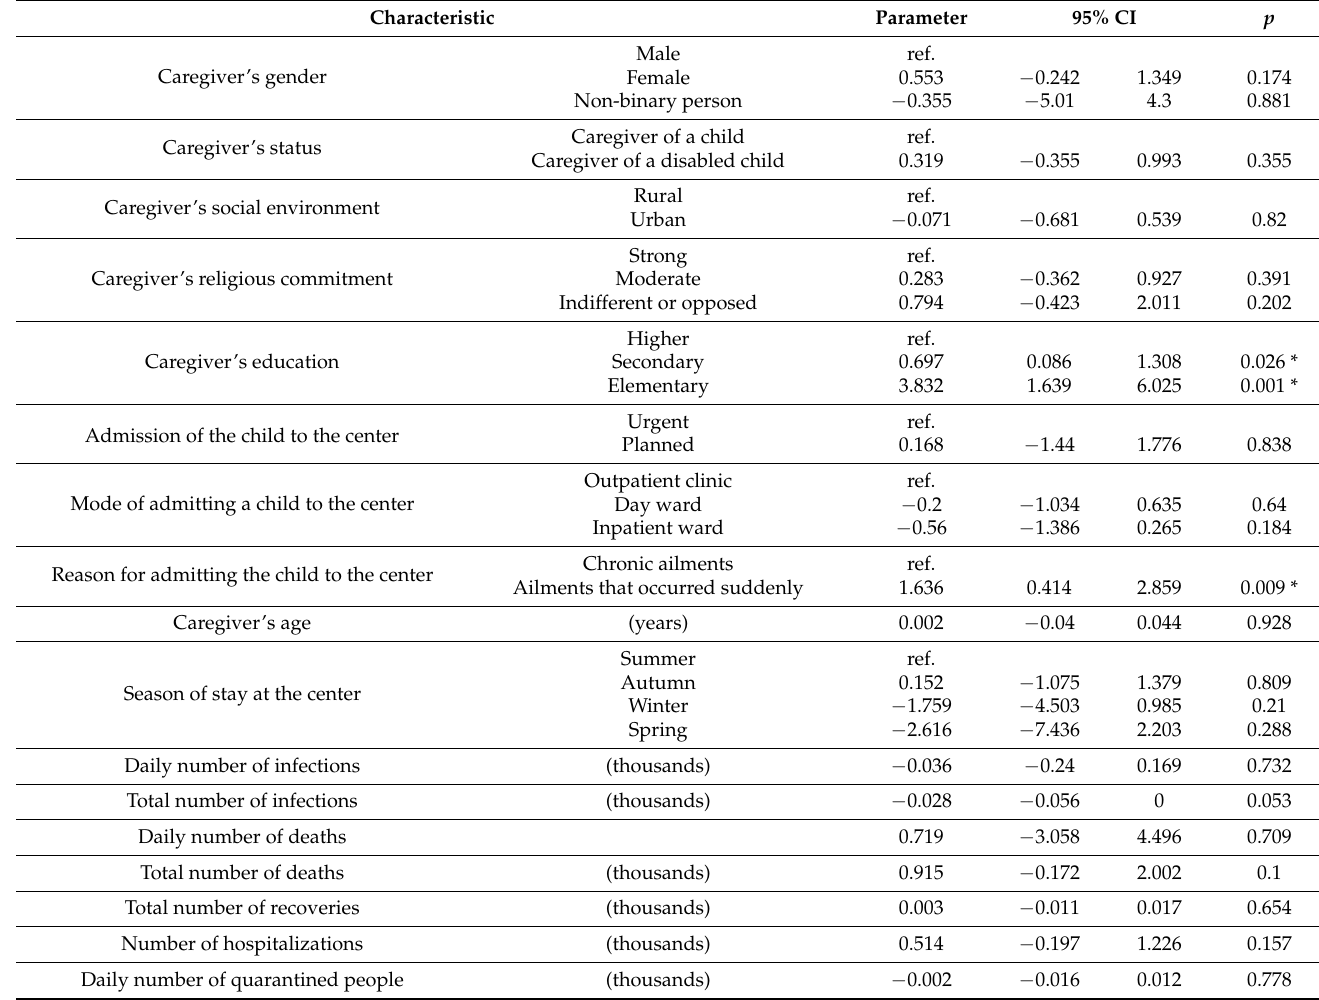
Table 11. Predictors differentiating the level of depression: multivariate